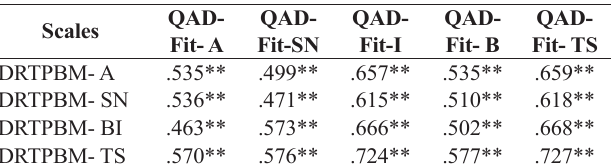
Table 5. Correlation Matrix between QAD-Fit and Portuguese ver- sion of